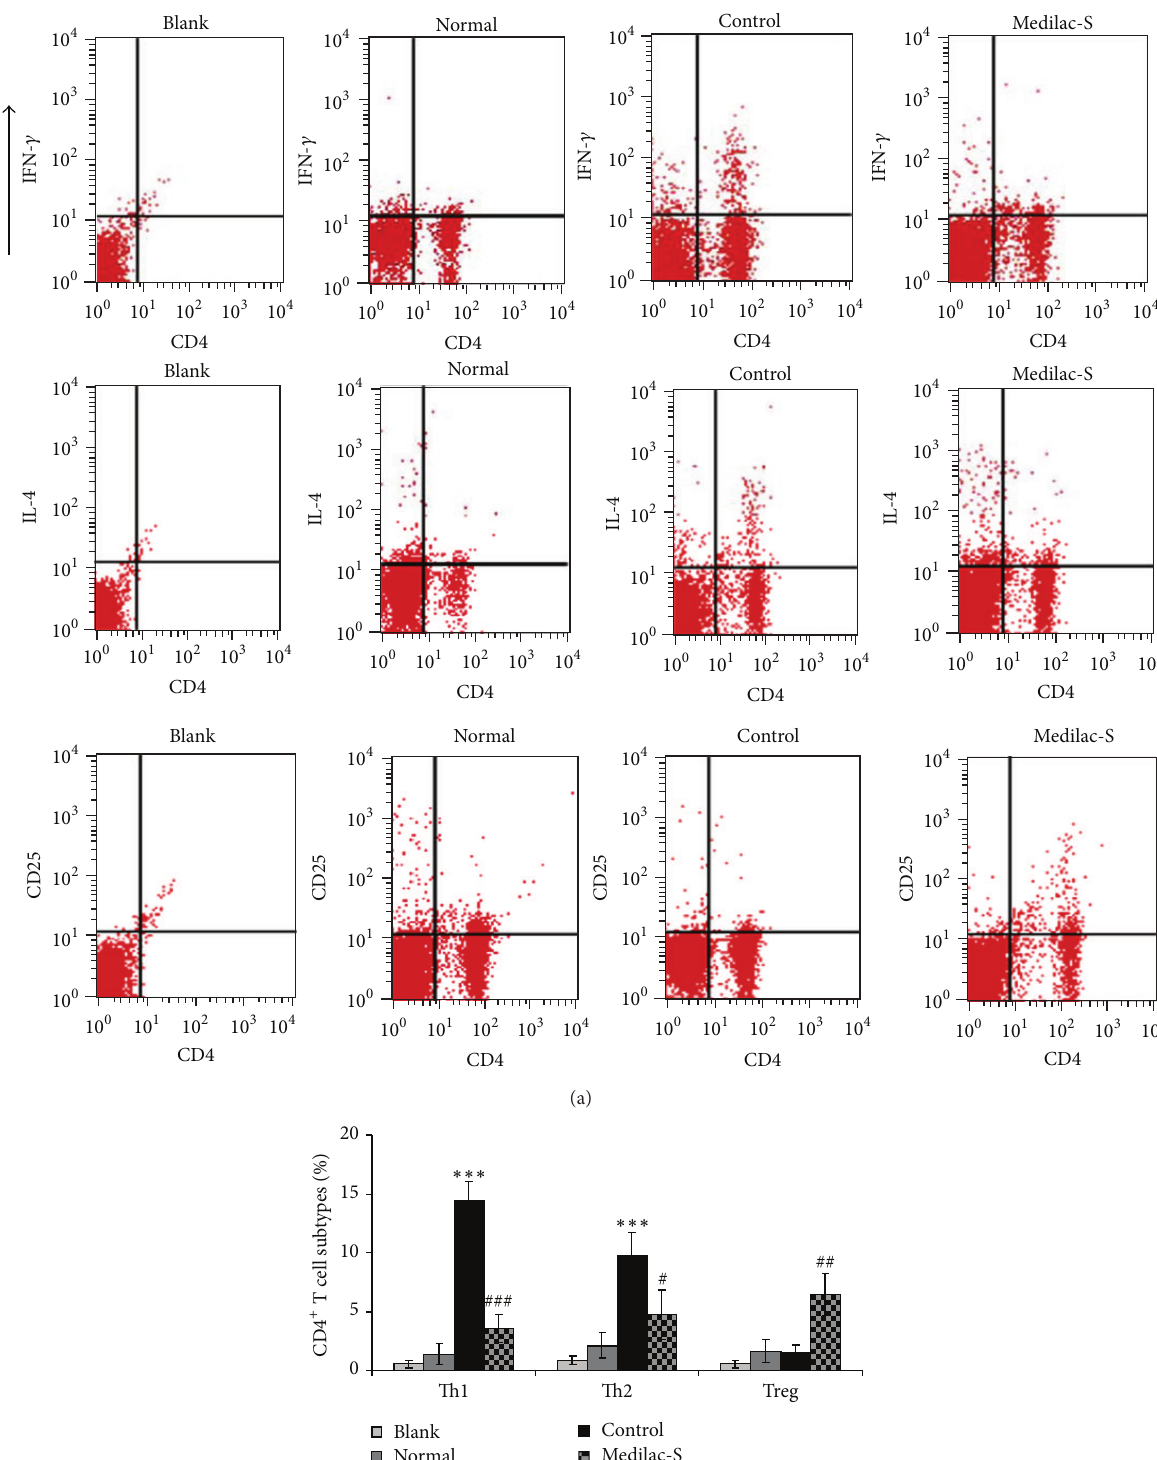
Figure 4: Analysis of subtypes of CD4 + T lymphocytes from the spleens of rats in groups. (a) FACS analysis of Th1 (CD4 + IFN- 𝛾 + ), Th2 (CD4 + IL-4 + ), and Treg (CD4 + CD25 + ). (b) Quantification of the percentages of Th1, Th2, and Treg in lymphocytes of the spleen. Our results demonstrated that significant higher activation of Th1 and Th2 in control group compared with the normal group. Medilac-S treatment decreased the ratios of Th1 and Th2 but increased the ratio of Tregs significantly compared with the control group. ( 𝑛 = 10 per group; ∗ compared with normal group, # compared with control group, ∗ or # 𝑃 < 0.05 , ∗∗ or ## 𝑃 < 0.01 , and ∗∗∗ or ### 𝑃 < 0.001